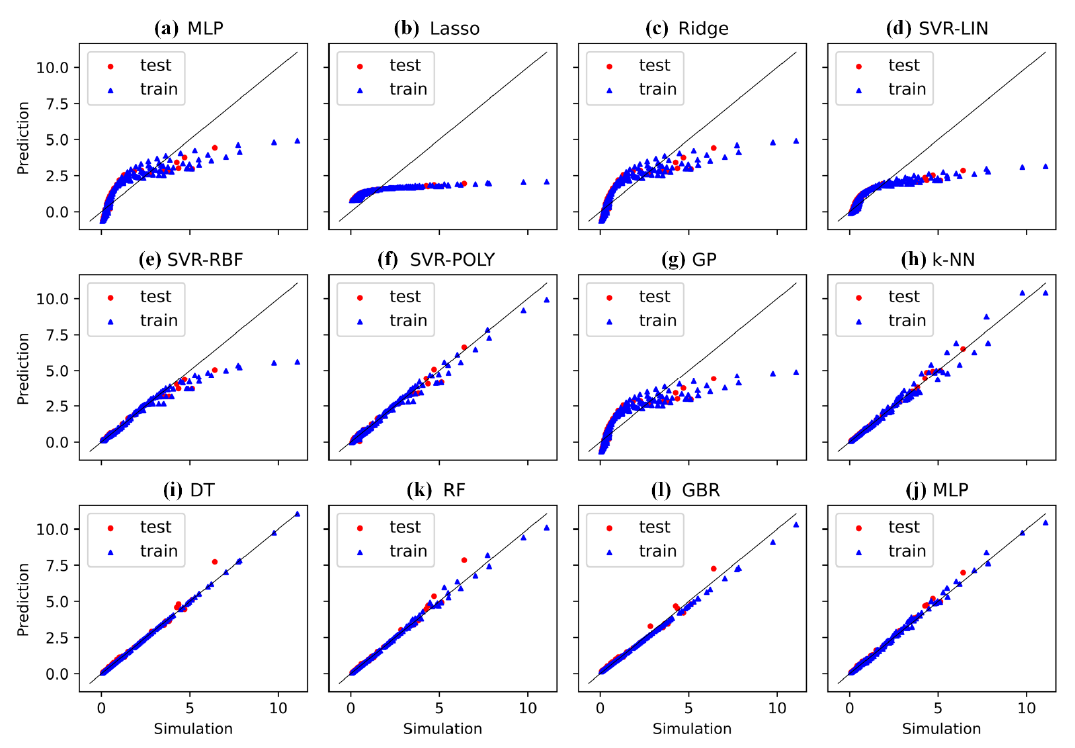
Figure 7. Simulation versus predicted values for shear viscosity of the LJ fluid, being the output of 12 different algorithms ( a – l ). Data points include both training and test data. The 45 ◦ identity line denotes the perfect match.